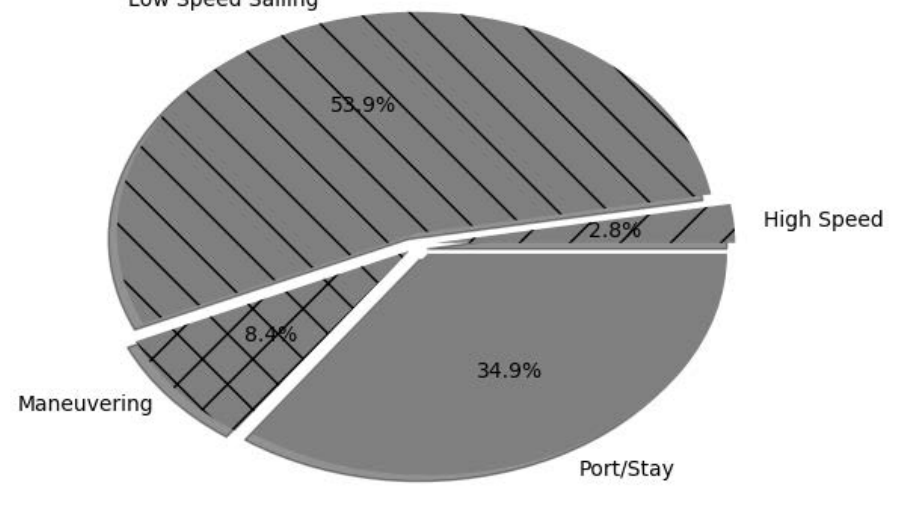
Figure 8. Share of time spent by the ship in each operational mode considered in the analysis.